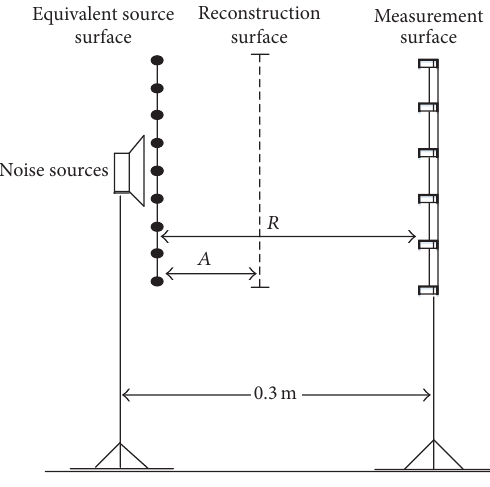
Figure 1: Geometrical arrangement